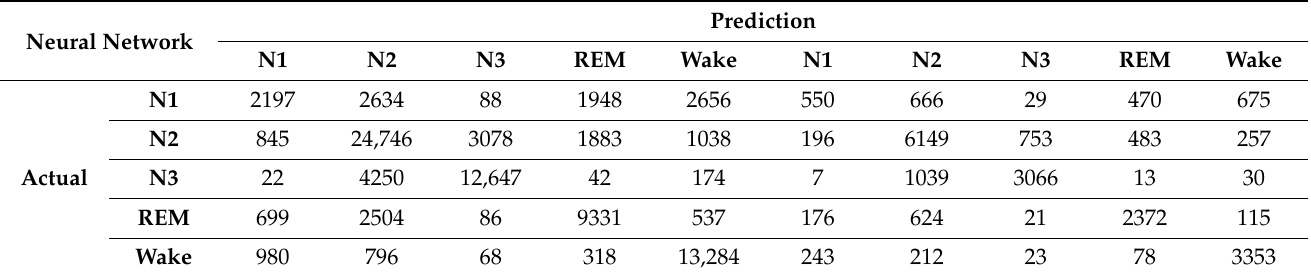
Table 5. Confusion matrix of the Neural Network Model using training and testing datasets for the classification of EEG features of the sleep stages W, N1, N2, N-3, and R.